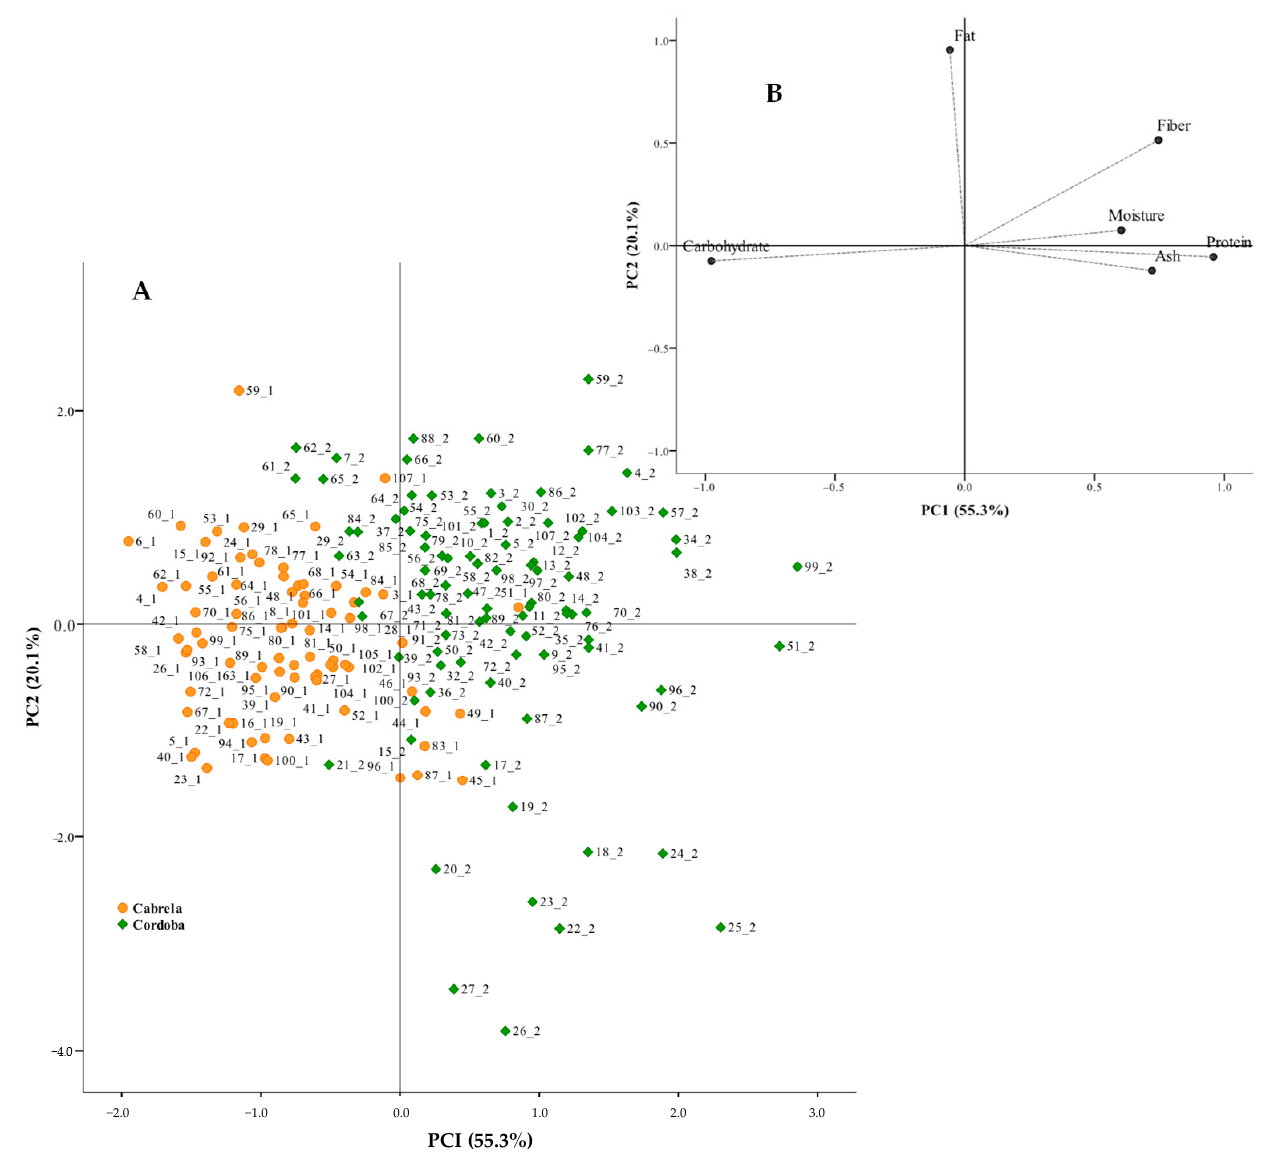
Figure 1. ( A ) Score plot of Portuguese common bean accessions ( n = 66) cropped in Cabrela and C ó rdoba, in a bi-dimensional space (PC1 and PC2), which accounted to 75.4% of the total variance. Different common bean accessions were identified according to Table S2, followed by numbers 1 or 2 to indicate the corresponding environment. 1 − Cabrela; 2 − C ó rdoba. ( B ) Projection of the variables responsible for accessions’